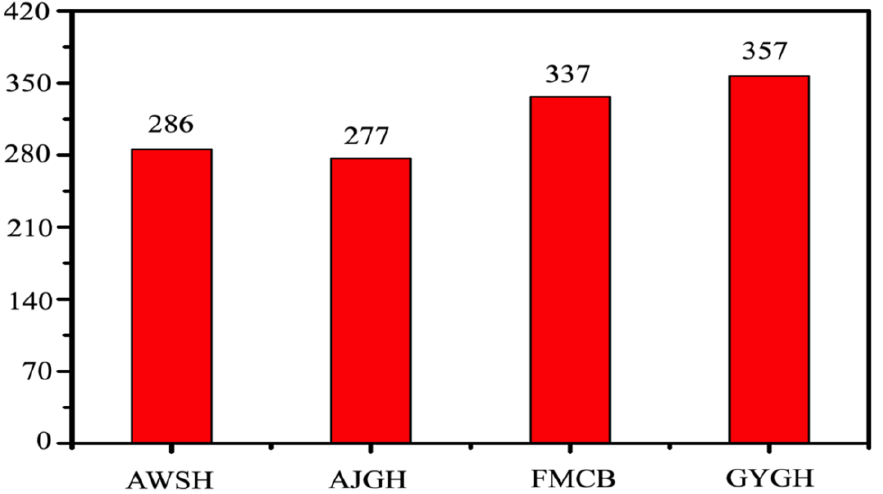
Figure 3. Total number of diabetes patients recorded in the four hospitals.